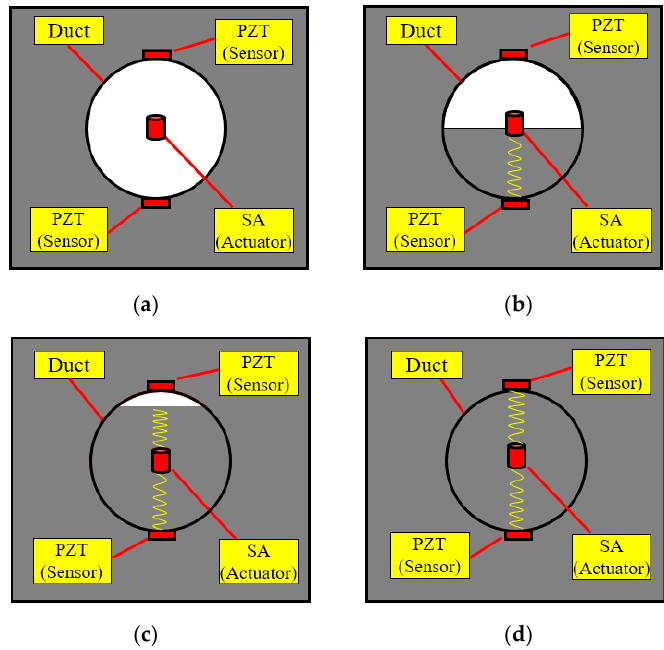
Figure 5. Principle of active sensing approach in monitoring of grouting compactness: ( a ) Empty duct; ( b ) Half grouting; ( c ) 90% grouting; ( d ) Full grouting.